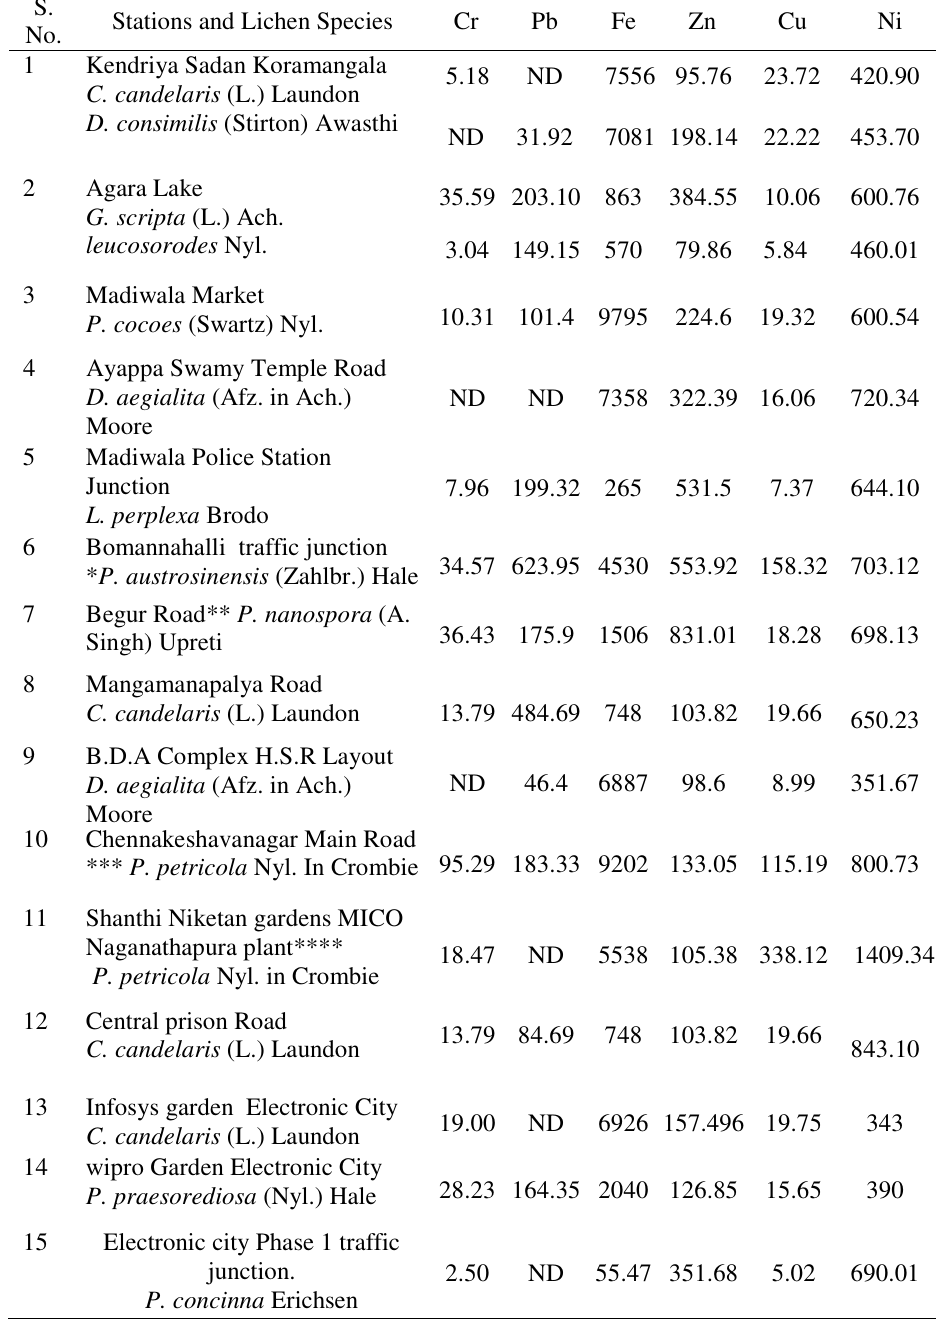
Table 3. Heavy metal concentration / µ g g –1 dry weight in selected litchens species.